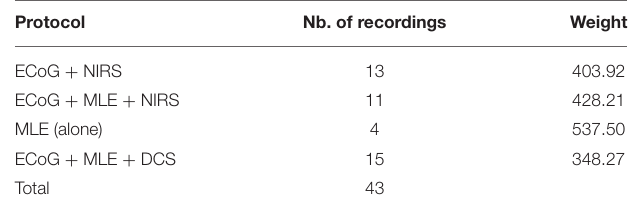
TABLE 1 | Number of rats used for each protocol.